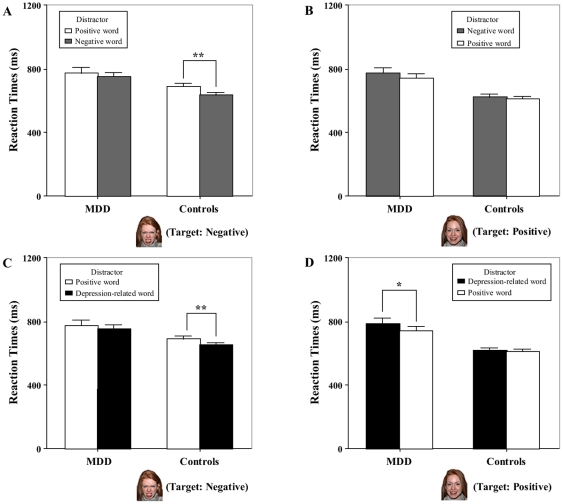
Comparisons of effects of emotional conflict between MDD patients and healthy controls.The emotional conflict effect induced by the traditional emotional incongruent (EI) trials (i.e., positive word distractor and negative face target, negative distractor - positive target) and emotional congruent (EC) trials (i.e., positive distractor - positive target, negative distractor - negative target) was illustrated in (A) (negative target) and (B) (positive target). The emotional conflict effect induced by the special EI (i.e., depression-related distractor - positive target) trials and EC (i.e., depression-related distractor - negative target) trials associated with the depression-related words was shown in (C) (negative target) and (D) (positive target). Error bars show standard errors. * p<.05, ** p<.01.